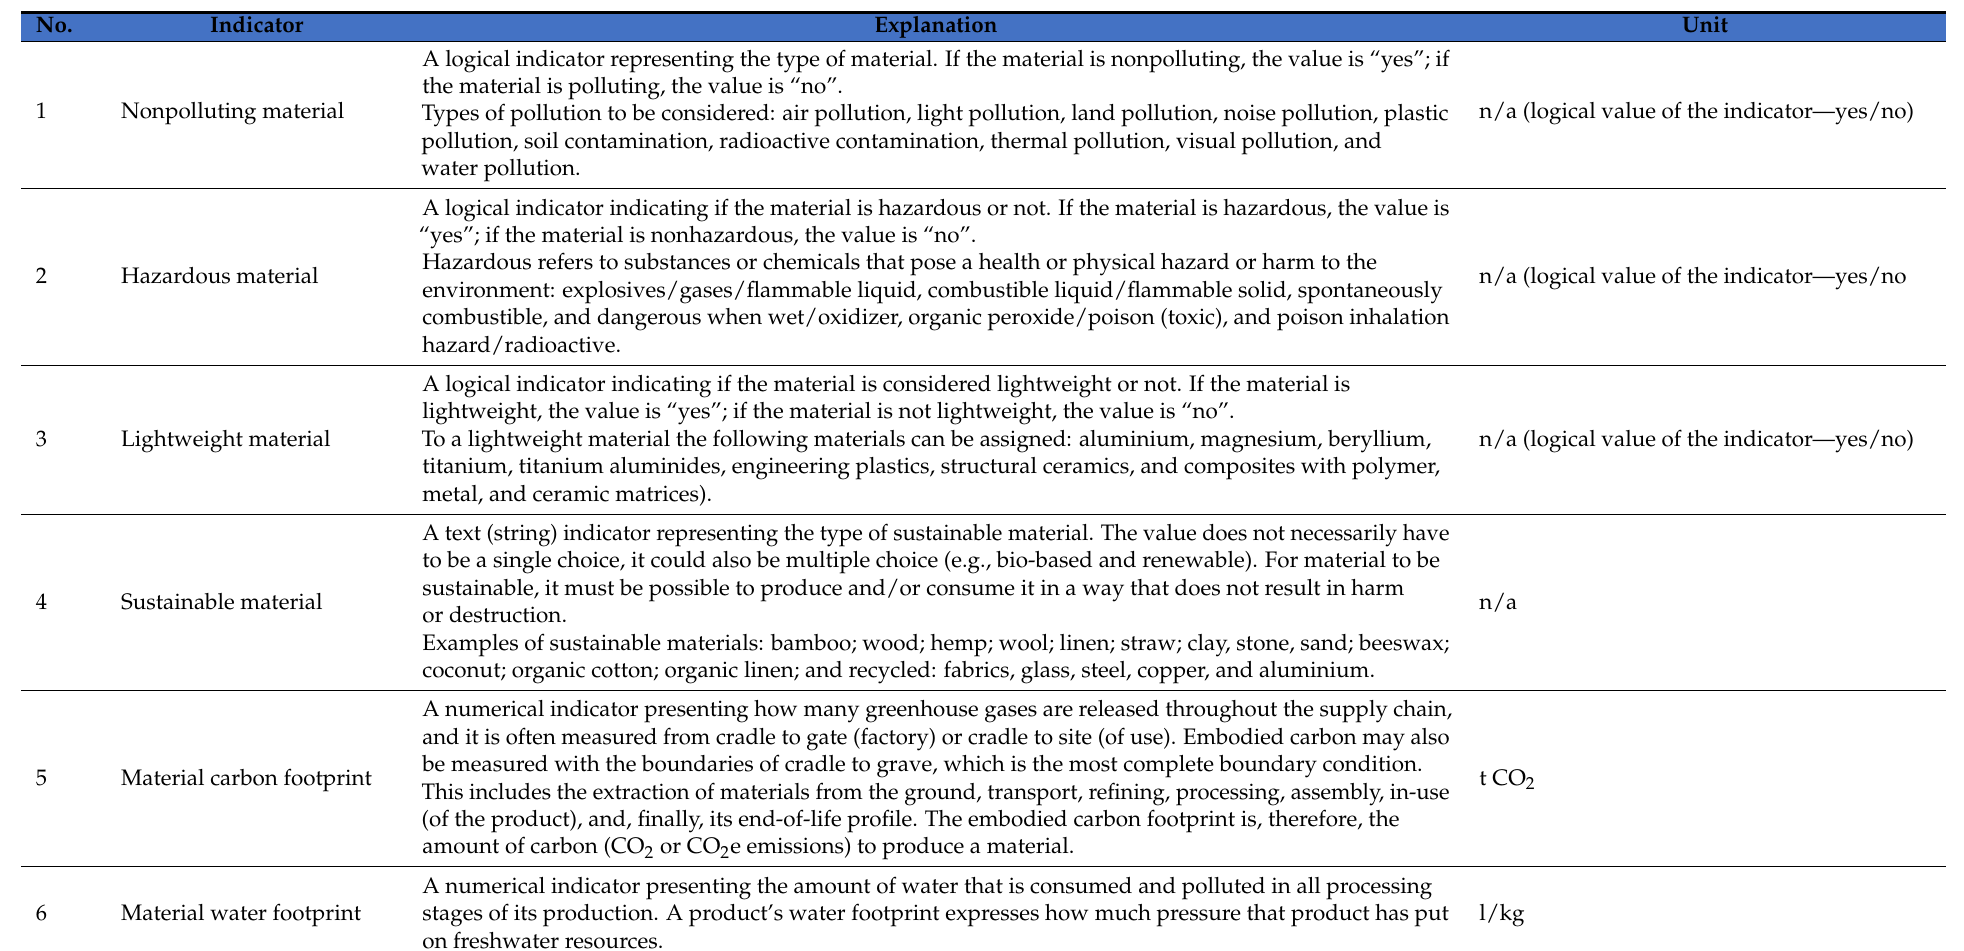
Table 5. Standardised key green indicators with redefined nomenclature (own